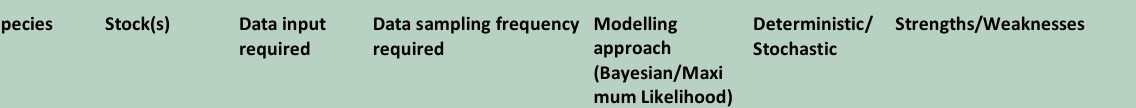
Table 3. Model matrix table for grey seals Species